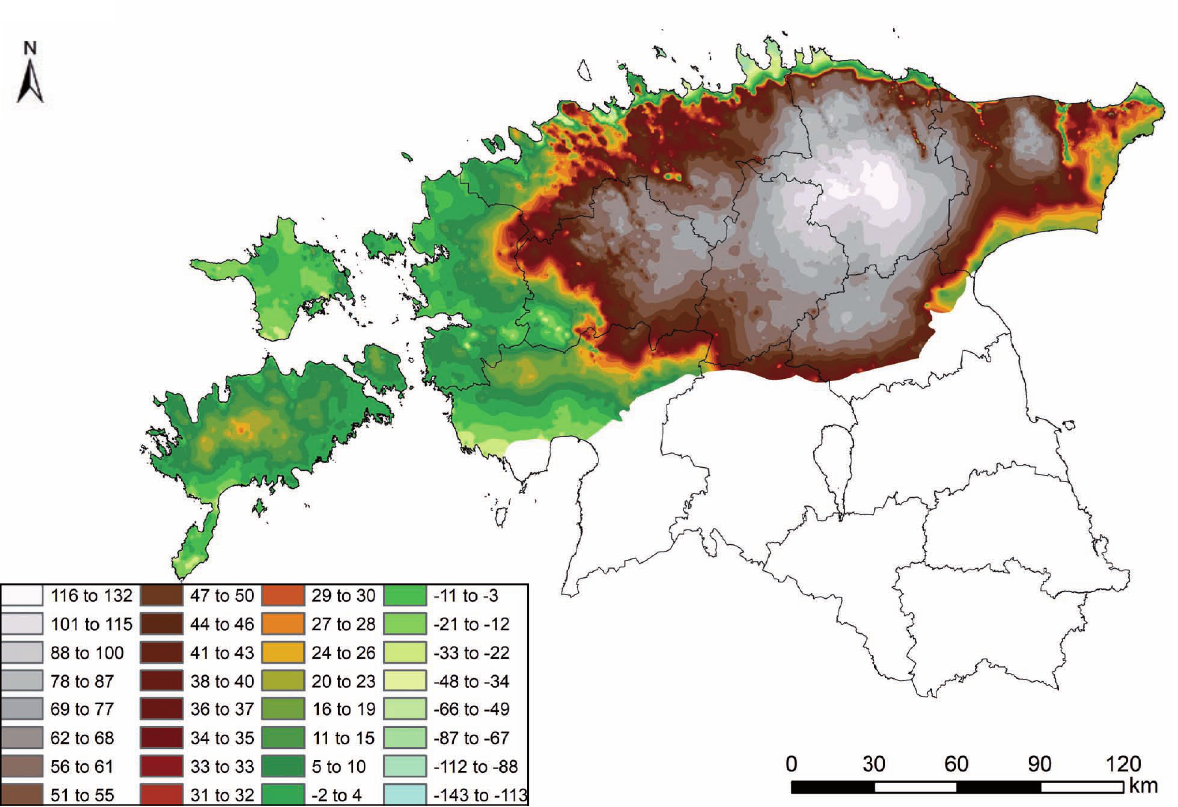
Fig. 6. The interpolated model of rock head elevation of the carbonate area. Surface values are metres from sea